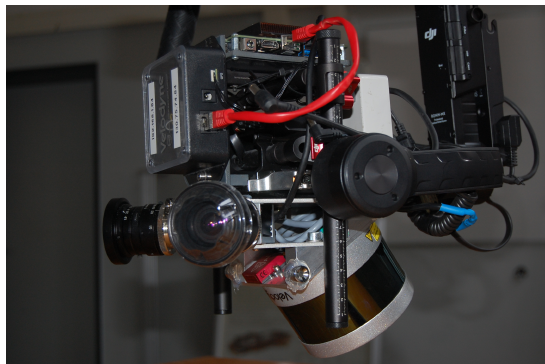
Figure 1. The multi-sensor platform attached to the gimbal.; the laser scanner and IMU are not used in this